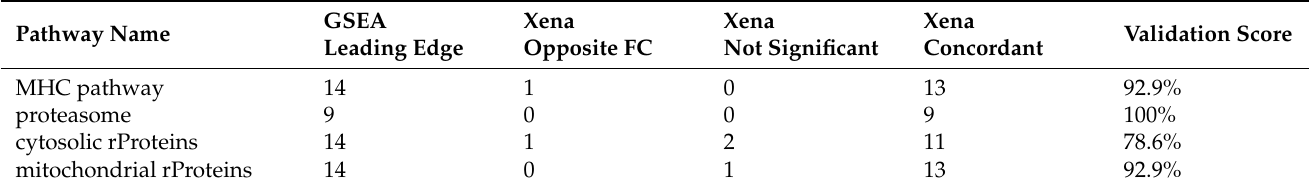
Table 4. Number of genes subjected to validation by the TCGA/GTEx databases and their outcomes.